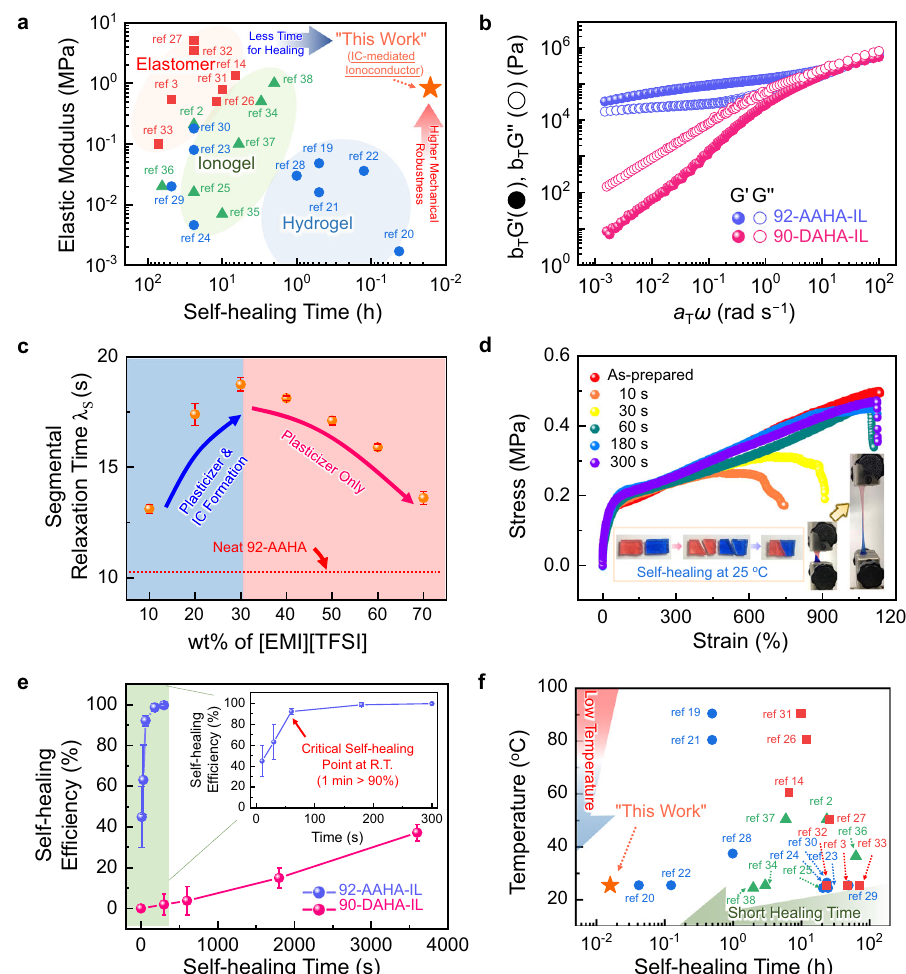
Fig. 1 Characteristics of highly stretchable and unprecedentedly fast self-healable ionoconductors. a Trade-off correlation between mechanical robustness and self-healing speed in conventional self-healing systems. b Time – temperature master curves of storage ( G ′ ) and loss ( G ′′ ) moduli for 92- AAHA-IL and 90-DAHA-IL. c In fl uence of weight fraction of introduced [EMI][TFSI] on segmental relaxation time of 92-AAHA-IL. The red-dotted line indicates the segmental relaxation time of neat 92-AAHA. Error bars represent standard deviation. d Tensile stress-strain curves of 92-AAHA-IL ionoconductor for various self-healing durations at 25 °C after complete cleavage. The inset shows photographs of the instantaneous self-healing process of 92-AAHA-IL. e Plots of self-healing ef fi ciency (%) of 92-AAHA-IL and 90-DAHA-IL versus repair time. The ef fi ciency was estimated from the toughness ratio between the healed and original ionoconductor. Error bars indicate standard deviation. f Comparison of performances measured in this work and previously reported self-healing systems, expressed in terms of self-healing time and corresponding healing temperature. Squares, circles, and triangles correspond to elastomer-, hydrogel-, and ionogel-based self-healing platforms,